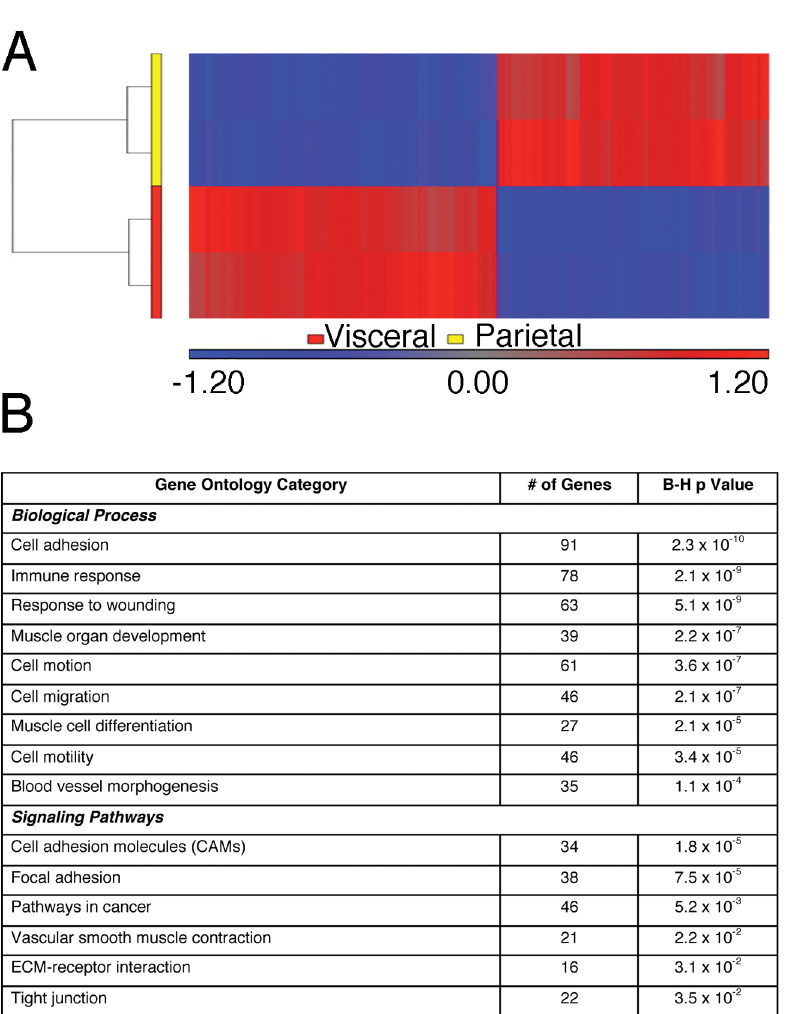
Figure 1. Visceral and parietal mesothelia have significantly different gene expression profiles. Microarray analysis was performed on visceral and parietal mesothelia isolated from adult mice. Hierarchical clustering of 1,728 probes separated the two cell types based on gene expression patterns. Vertical dendrograms represent the individual samples, of which there are two replicates for each tissue type (A). Values shown are log base 2 and bright red, bright blue, and gray indicate the highest, lowest, and median normalized signal values respectively. Overrepresented functional categories were generated for both tissue types (B). B-H p values represent the Benjamini and Hochberg corrected p value, calculated by the online database and functional analysis program, DAVID, using Fisher’s Exact test.